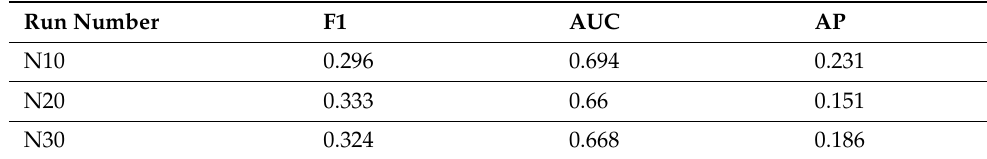
Table A3. Lowered regularisation for